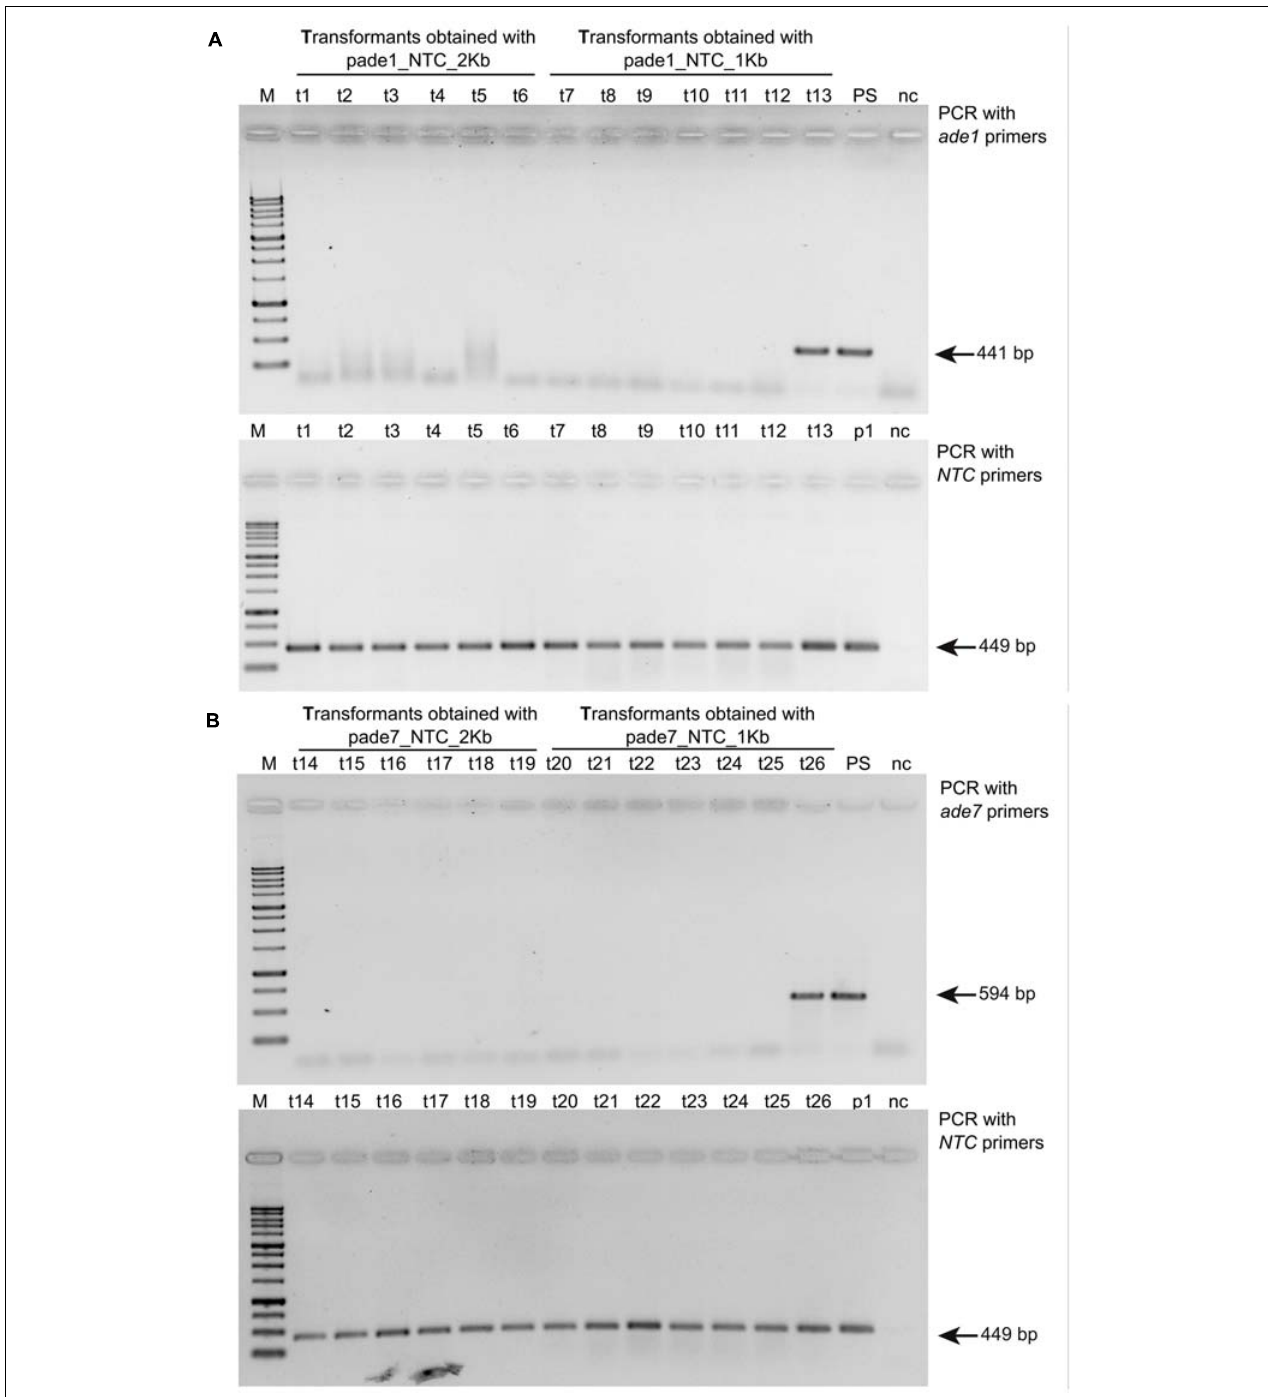
FIGURE 3 | Gel images showing PCR confirmation of ade1 or ade7 deletion in Ophiostoma novo-ulmi transformants. (A) Total genomic DNA samples from twelve pink colony transformants and one white colony transformant (t13) were amplified with a de1 specific primer pair ade1F-809 and ade1R-1221 (top panel) and nat1 marker primers ntcF_562 and ntc_975_R (bottom panel). Lanes: M, 1 kb plus (FroggaBio); t1 through t6 and t7 through 13, 174_68 (cid:49) mus52 transformants obtained using pade1_NCT_2kb and pade1_NTC_1kb, respectively; PS, parental strain 174_68 (cid:49) mus52 ; p1, pA-NTC-OSCAR; nc, negative H 2 O control. (B) Total genomic DNA samples from twelve pink colony transformants and one white colony transformant (t26) were amplified with a de7 specific primer pair ade7F-368 and ade7R-809 (top panel) and nat1 marker primers ntcF_562 and ntc_975_R (bottom panel). Lanes: M, 1kb plus (FroggaBio); t14 through t19 and t20 through 26, 174_68 (cid:49) mus52 transformants obtained using pade7_NTC_2kb and pade1_NTC_1kb, respectively; PS, parental strain 174_68 (cid:49) mus52 ; p1, pA-NTC-OSCAR; nc, negative H 2 O